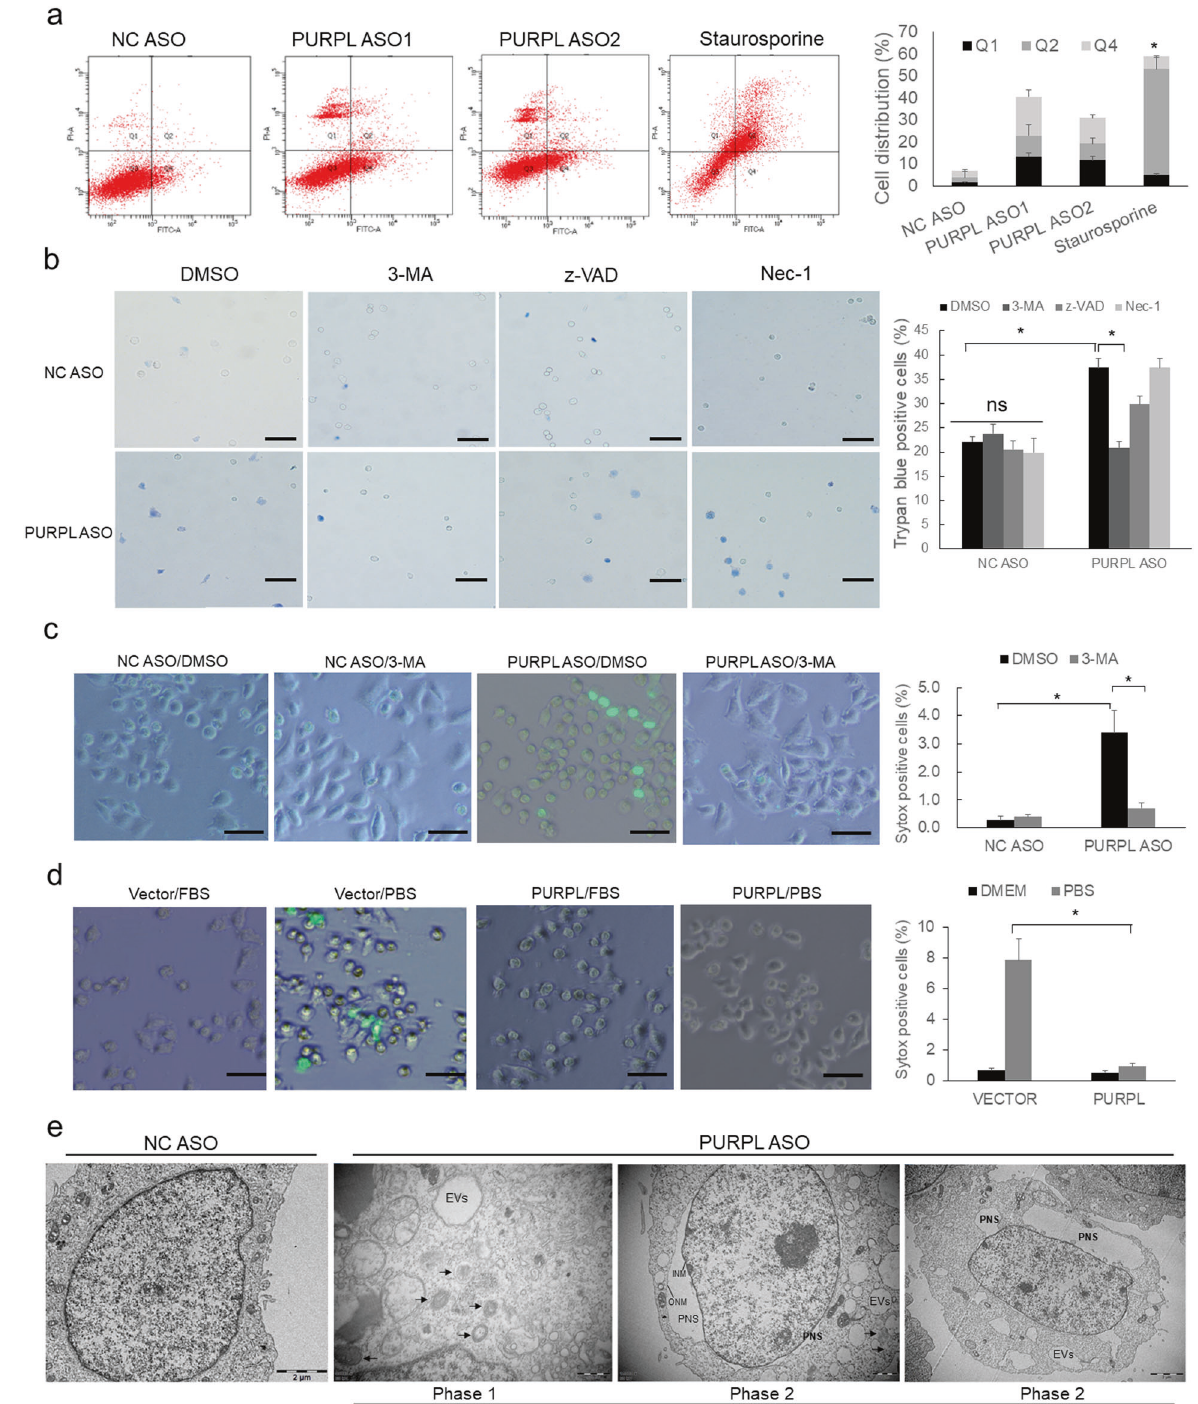
Fig. 5 PURPL functions in repressing autophagic cell death. a The cell distribution was detected by fl ow cytometry with Annexin V/PI double staining in A375 melanoma cells after depletion of PURPL. Cells treated with 200 nM Staurosporine for 24 h were used as apoptosis control. b Trypan blue staining was performed to detect the major cell death type induced by PURPL depletion in melanoma cells with 3-MA (5 mM for 5 h), zVAD (100 μ M for 24 h), and Nec-1 (50 μ M for 24 h) treatments. Scale bar, 100 μ M. c Sytox green staining was performed to evaluate the effects of 3-MA treatment on autophagic cell death induced by PURPL depletion. Scale bar, 100 μ M. d Sytox green staining was performed to evaluate the role of PURPL in repressing starvation-induced autophagy in melanoma cells. PBS-treated melanoma cells were used as positive control for autophagy induction. Scale bar, 100 μ M. e Autophagic cell death was detected by transmission electron microscopy (TEM). Arrows indicates autophagosomes. Typical features of autophagic cell death includes the formation of empty vacuoles (EVs) and perinuclear space (PNS) by the separation of outer nuclear membrane (ONM) and inner nuclear membrane (INM). Scale bar, 2 μ M. One-way ANOVA and Dunnett ’ s multiple comparison test. Means ± s.d., * p < 0.05, ** p < 0.01, *** p < 0.001.